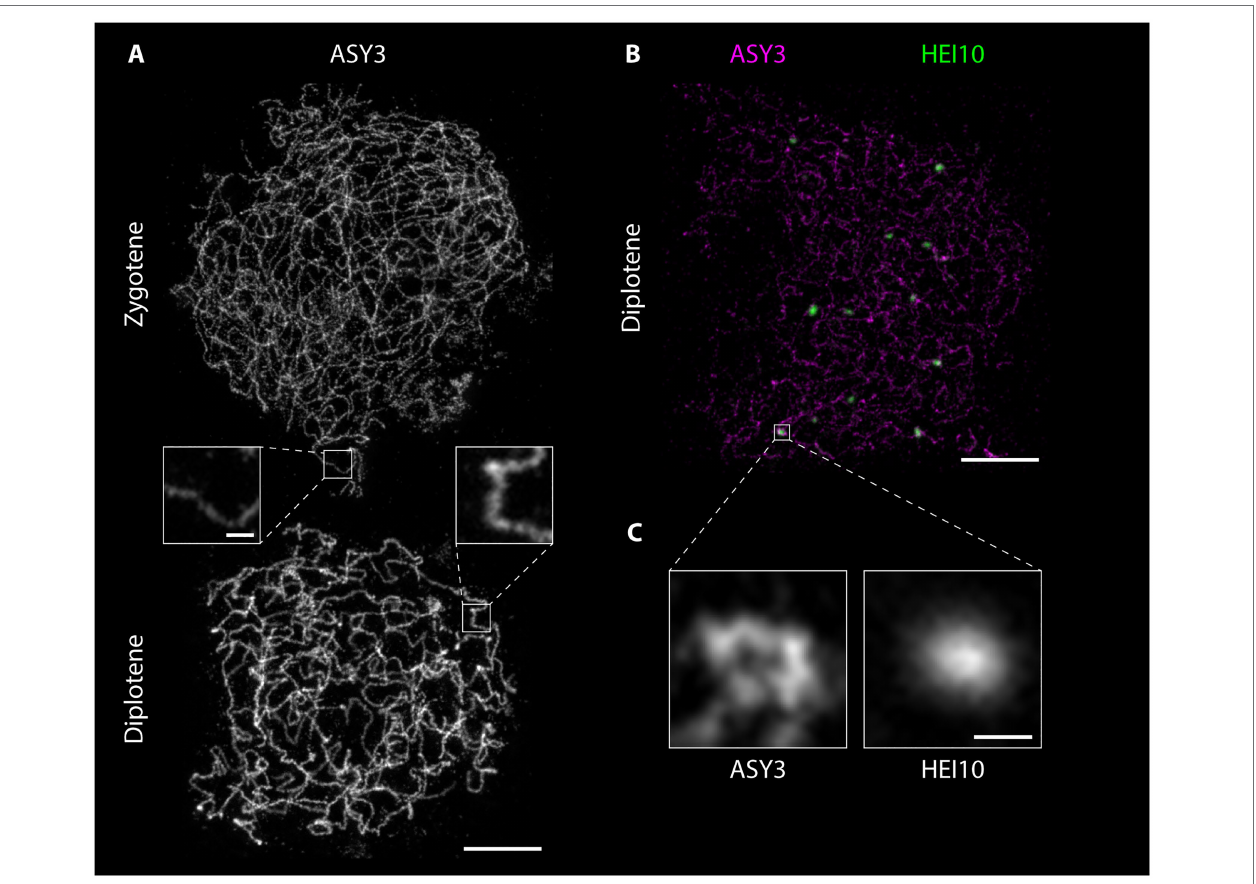
FIGURE 6 | Detergent-spread male meiotic nuclei were stained for the axial element protein ASY3 (A) or ASY3 and the ubiquitin ligase HEI10 (B) and imaged with a STED nanoscope. Scale Bar: 2 μ m. Panel (C) shows a magnification of the highlighted region in panel (B) . Scale Bar: 200